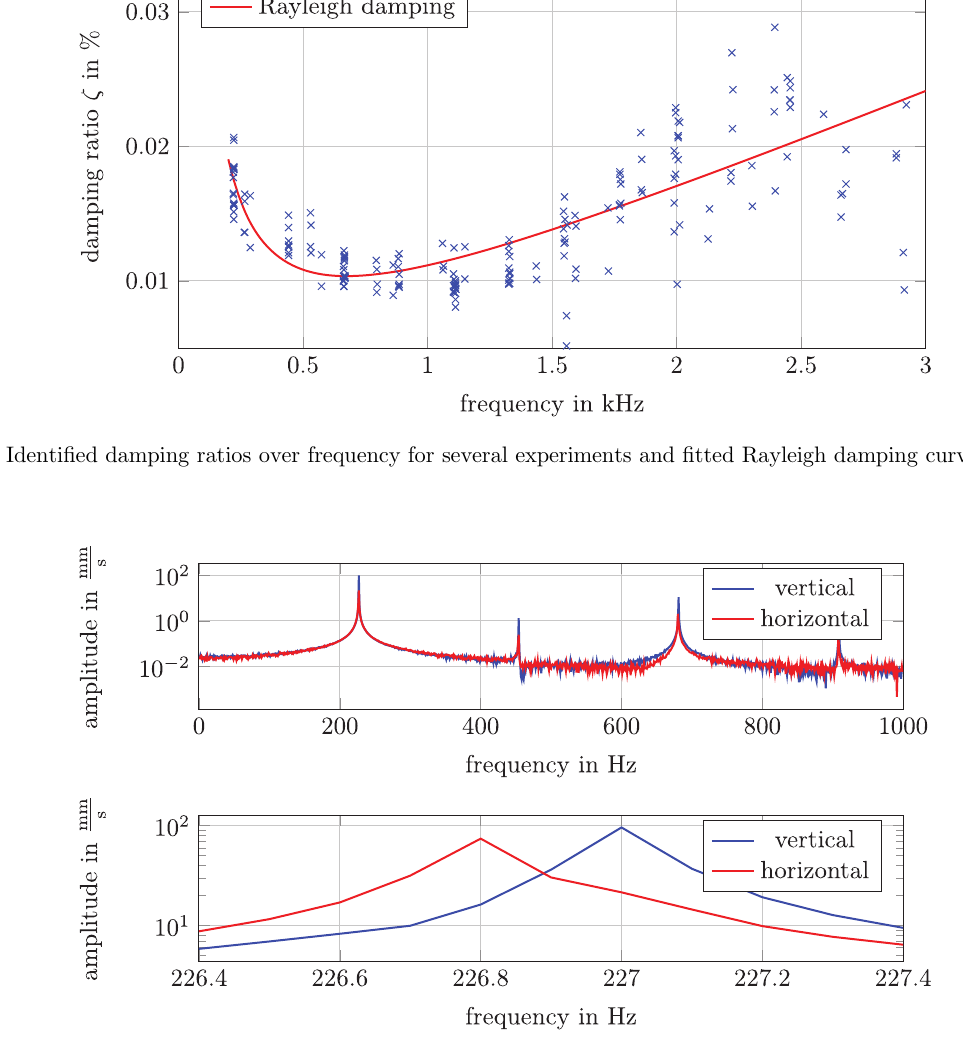
Figure 5. Fourier transformed velocity signal in the two planes of